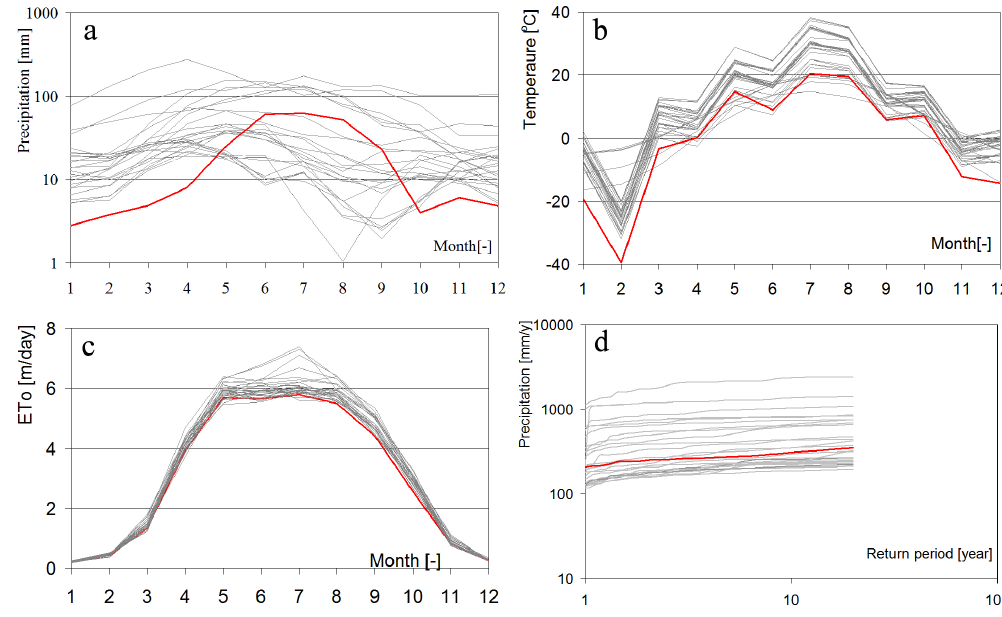
Fig. 5. Precipitation monthly variations (a) , monthly average temperature (b) , monthly ETo (c) and return period of annual total precipitation (d) for GCM based results and observations for 1979–1998 at BYBLK meteorological